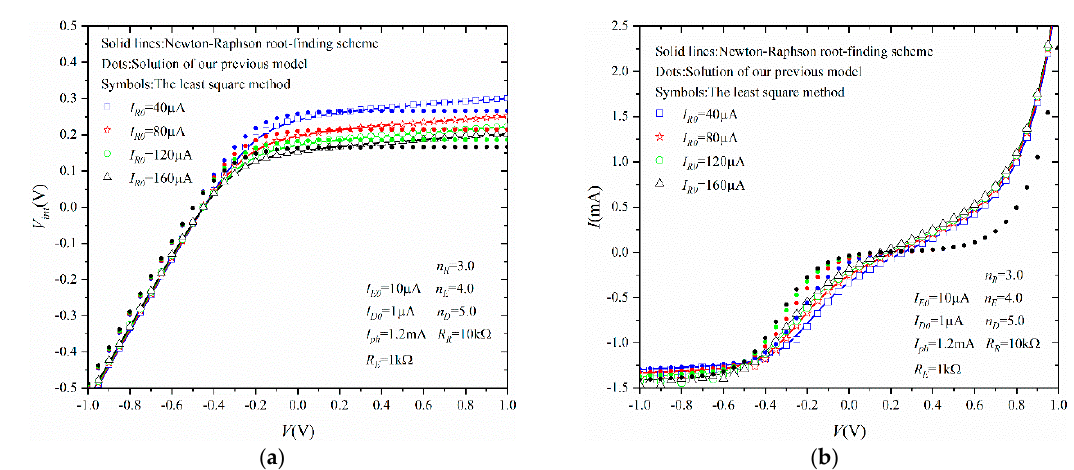
Figure 6. ( a ) V int ( V ) and ( b ) I ( V ) of the circuit in Figure 2 for different I R 0 .